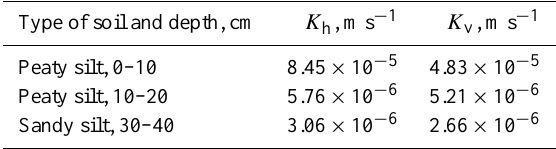
Table 6. Vertical ( K v ) and horizontal ( K h ) saturated hydraulic con- ductivity from undisturbed soil